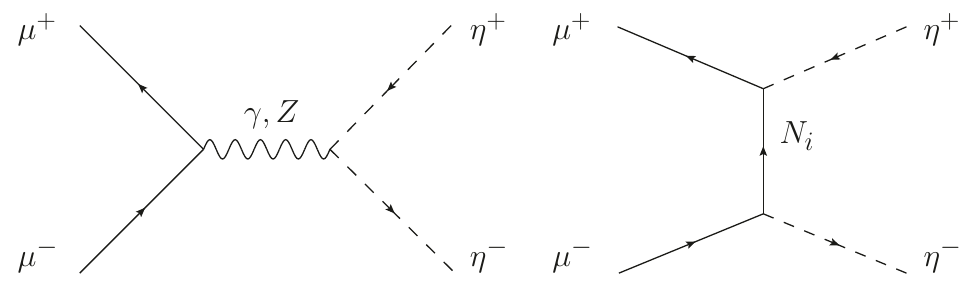
Figure 4 . Charged scalar pair production at the muon